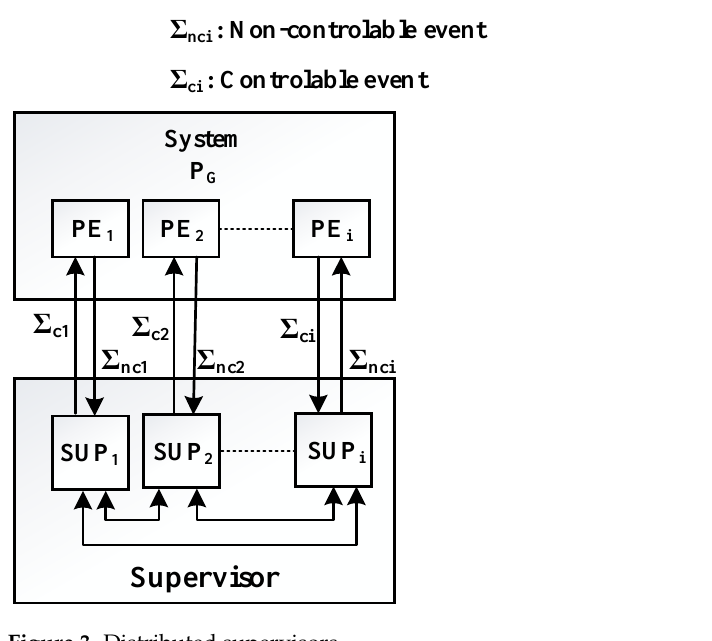
Figure 3. Distributed supervisors.